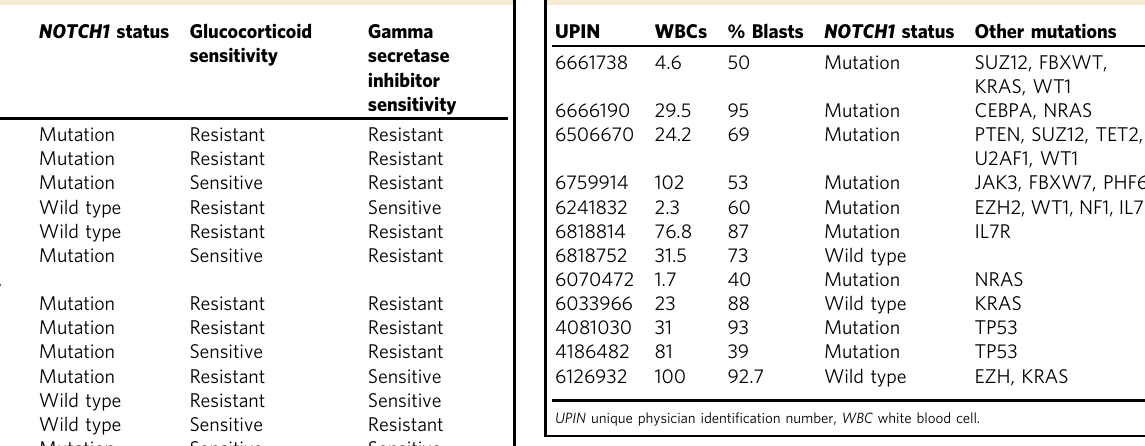
Table 1 Panel of cell lines used in the study. Table 2 Patient samples used in the study.